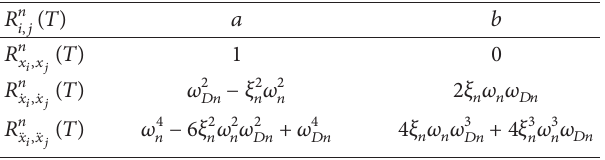
Table 1: Values of 𝑎 and 𝑏 for the CCFA of 𝑛 th modal displacement, velocity, and acceleration